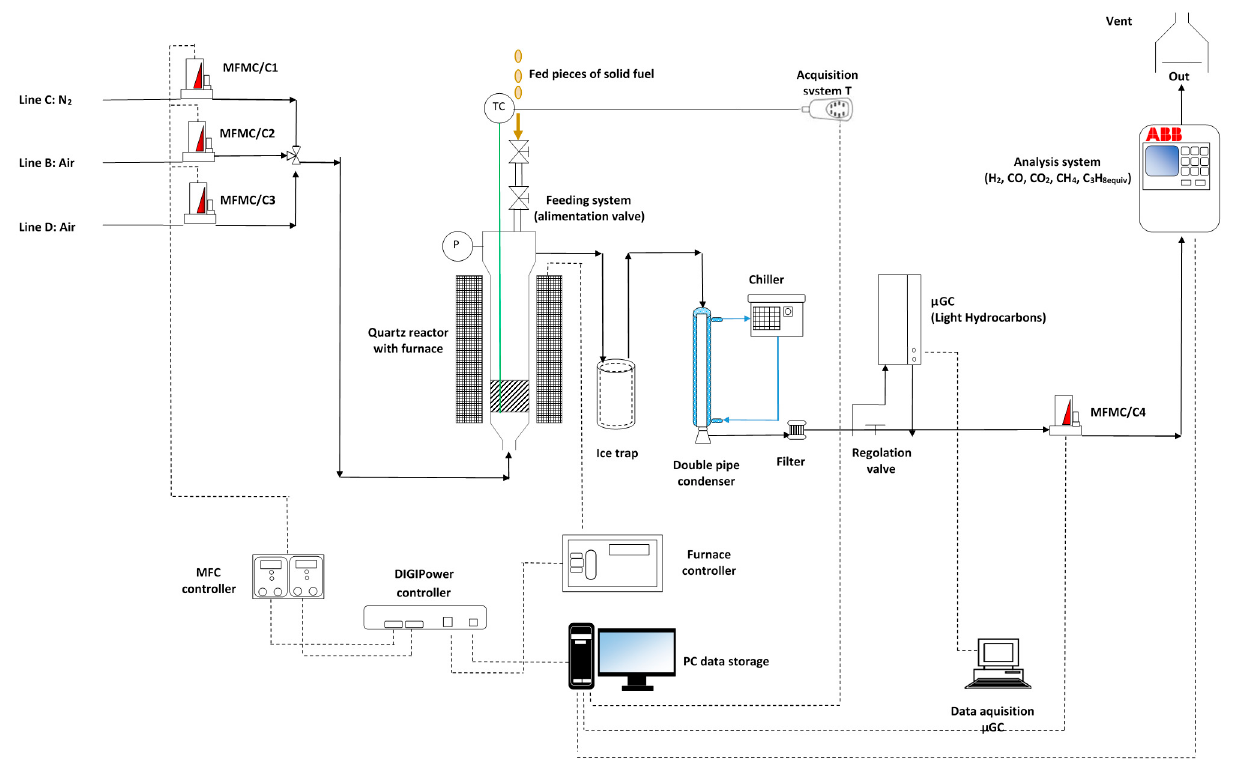
Figure 2. Schematic view of the laboratory-scale experimental apparatus for devolatilization tests . Devolatilization products left the reactor from its top, together with the fluidizing agent which also served as a carrier; condensable species were separated by an ice trap and a double-pipe glass condenser at 0 °C. The composition of dry product gases was measured online by an ABB analysis system and a micro gas-chromatograph ( μ CG) AG- ILENT 490 (see [36] for further details). The ABB system measured the volume percent- ages of CO, CO 2 , CH 4 and H 2 , and the overall hydrocarbons content as ppm v of equivalent C 3 H 8 . The raw values of equivalent C 3 H 8 measured by the ABB system included CH 4 con- tribution; in this work, the quantity presented as “equivalent C 3 H 8 ” is intended as already reduced by the contribution of CH 4 . From here on, “equivalent C 3 H 8 ” means “hydrocar- bons other than methane”.